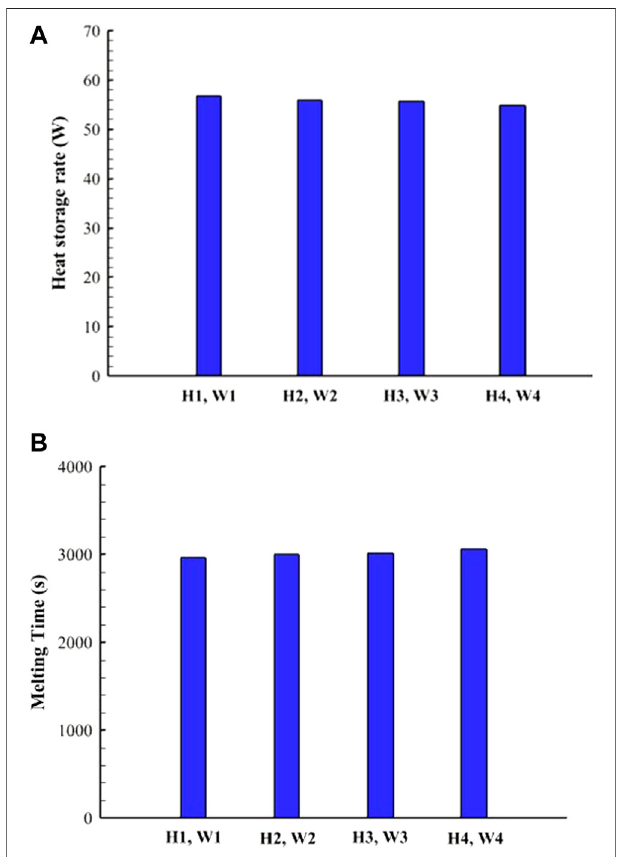
FIGURE 6 | (A) Heat storage rate; (B) melting time for various dimensionsoftheT-shaped fi nshead(thesizesofthe fi nsbodyarethesame).